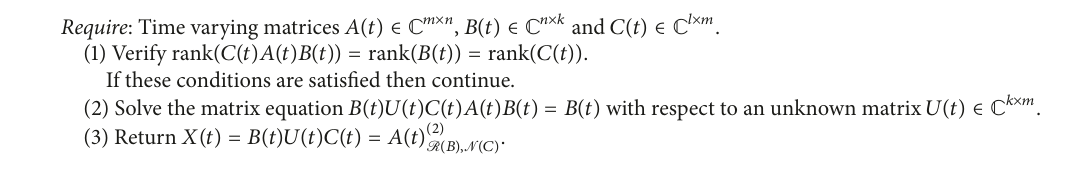
Algorithm 3: Computing a {2} -inverse with the prescribed range and null space.